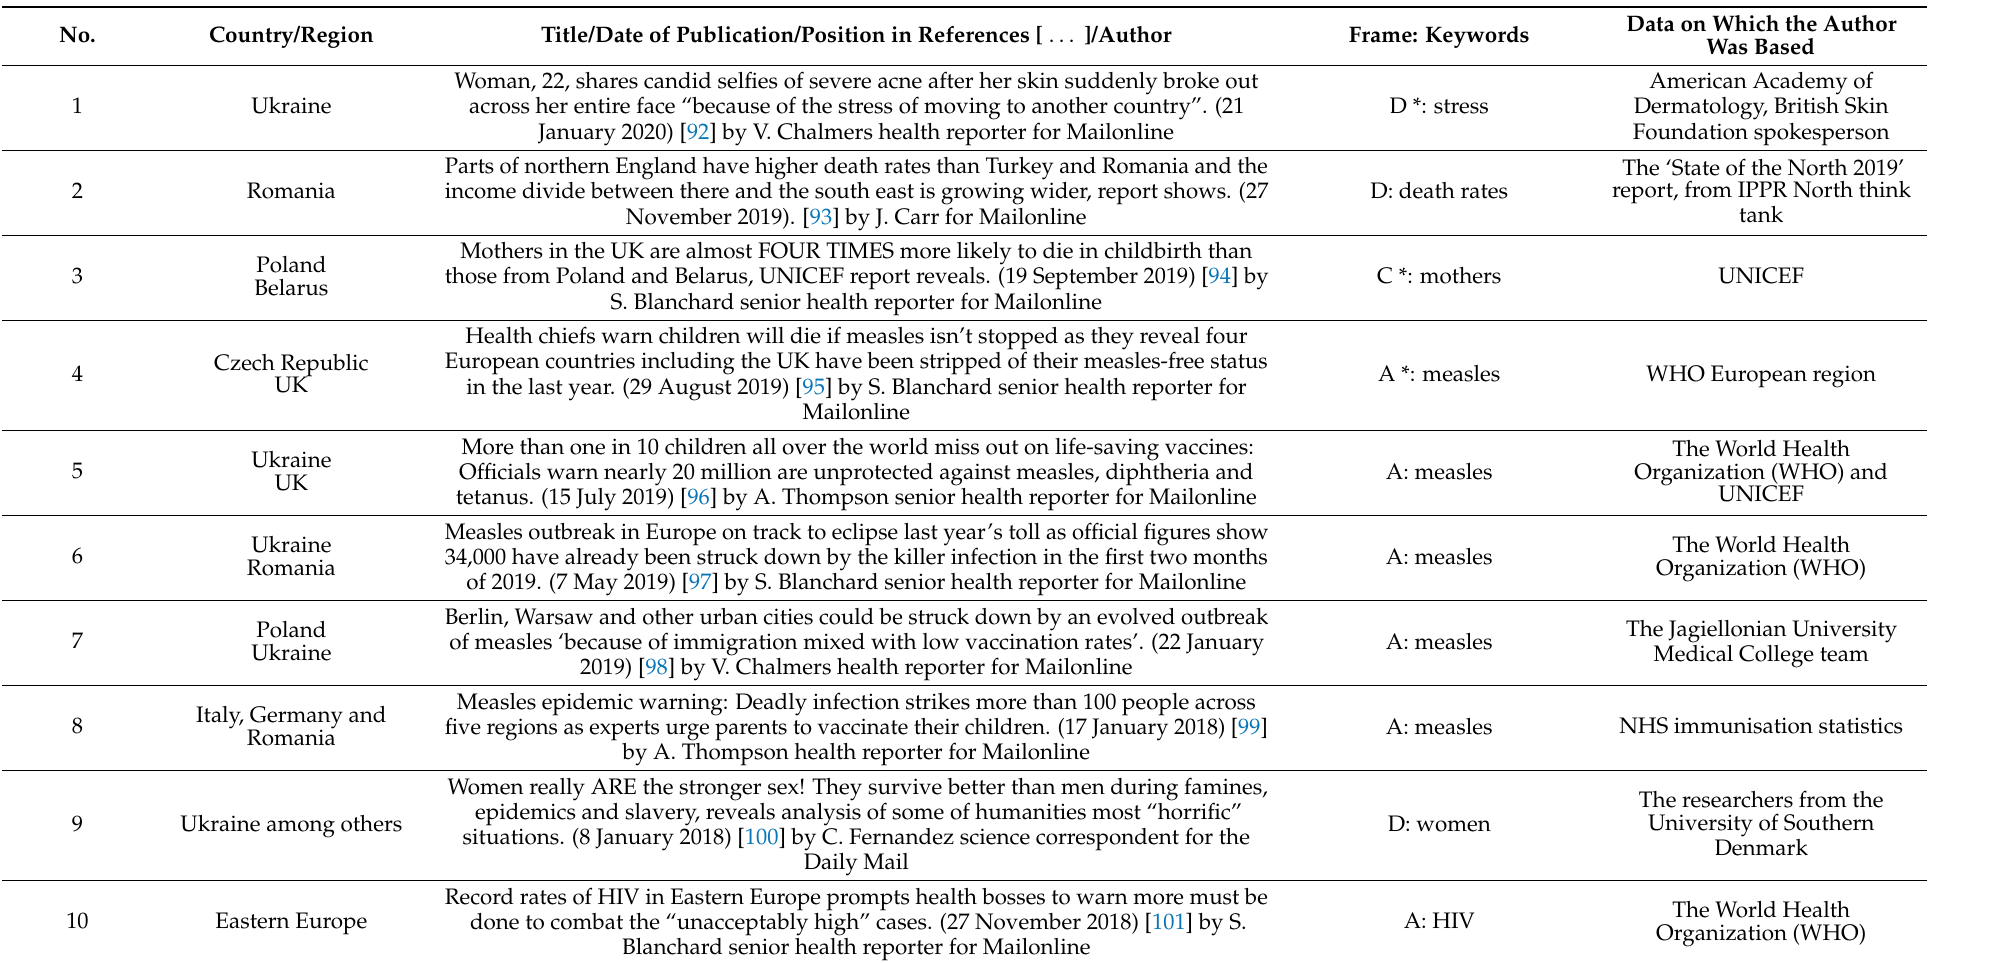
Table A1. FRAMES and Keywords in UK Tabloid Daily Mail Headlines and Text,